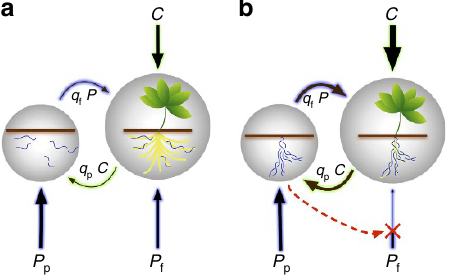
Figure 2 | The effect of phosphorus restriction on the mutualistic system. ( a ) Plants acquire phosphorus and carbon, whereas mycorrhizal fungi acquire phosphorus. Plants trade carbon to mycorrhizal fungi in exchange for phosphorus. ( b ) Mycorrhizal fungi restrict the ability of plants to directly acquire phosphorus (red cross). This restriction makes plants reliant on fungal phosphorus, so plants invest more into acquiring carbon directly and trade more carbon to compete for phosporous. The increased flows of carbon in trade favour mycorrhizal fungi that transfer more phosphorus.